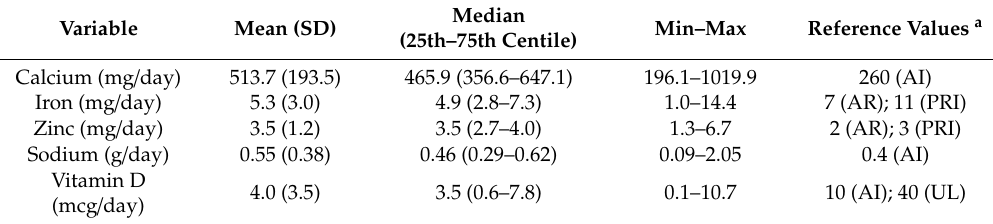
Table 8. Daily dietary intake of minerals and vitamin D in infants aged 6 ≤ months < 12 months ( n = 66) † .